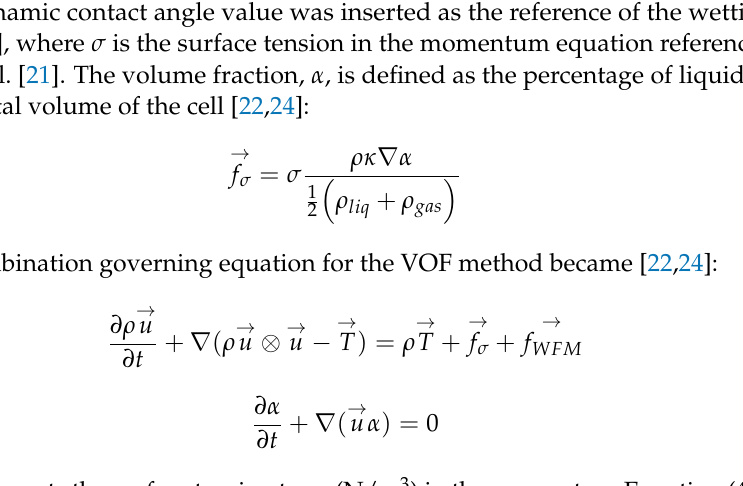
Figure 5. Unit Vectors on the Wall